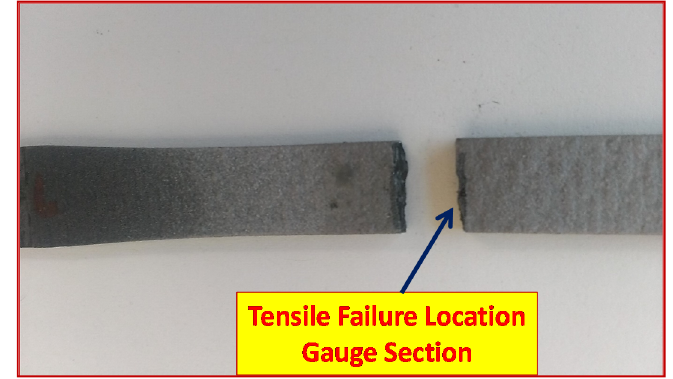
Figure 8. Test specimen failure.